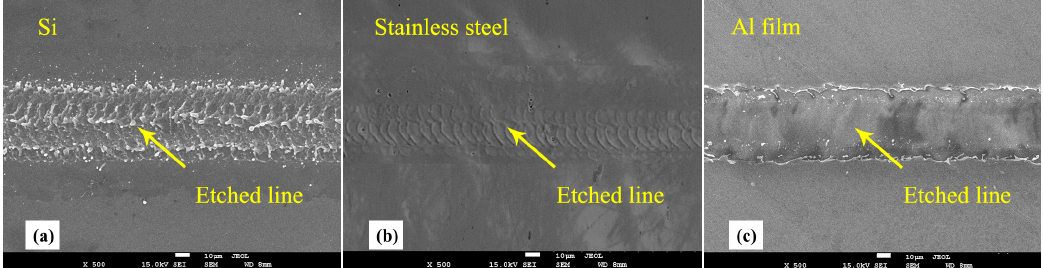
Figure 4. Scanning electron microscopy (SEM) images of single line etched by nanosecond laser: ( a ) Si, ( b ) stainless steel and ( c ) Al film on quartz glass. The etching energy is 38.6 μ J , 20.0 μ J , and 31.5 μ J .